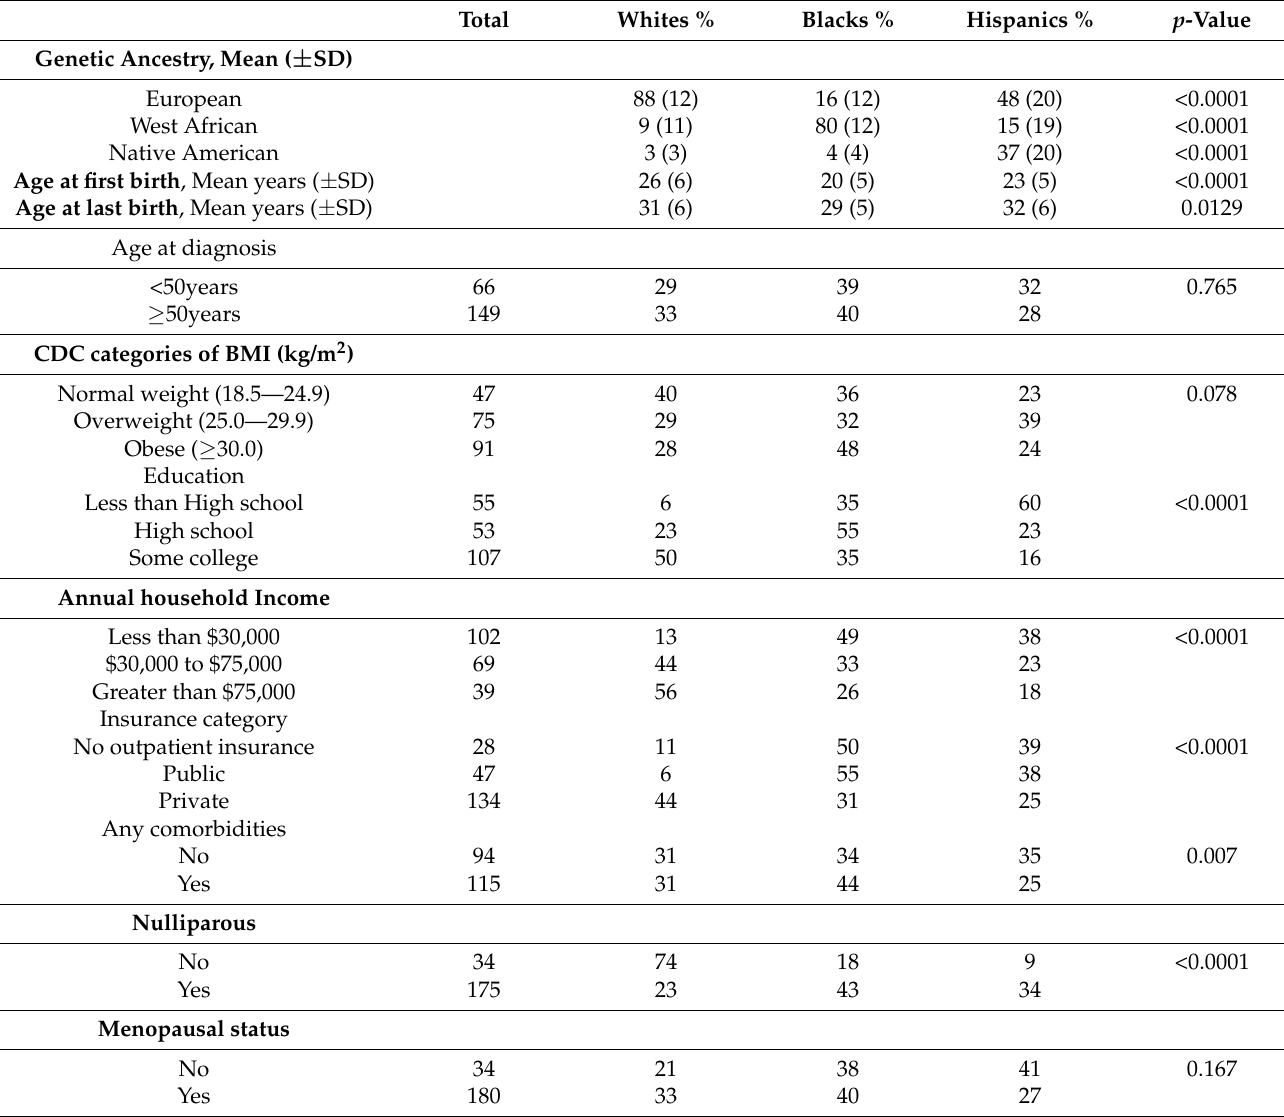
Table A4. Distribution of demographic and clinical characteristics of BCCC